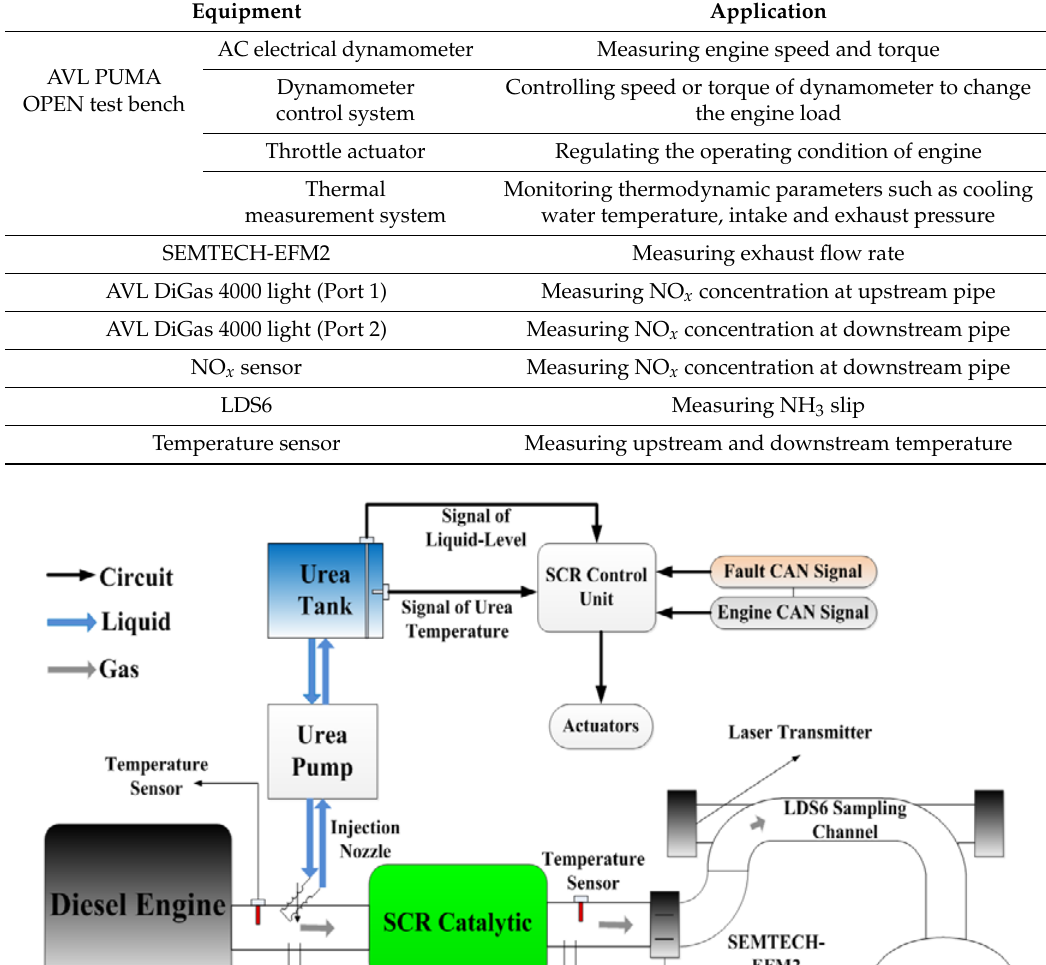
Table 3. Measuring and monitoring equipment. Table 3 . Measuring and monitoring equipment.